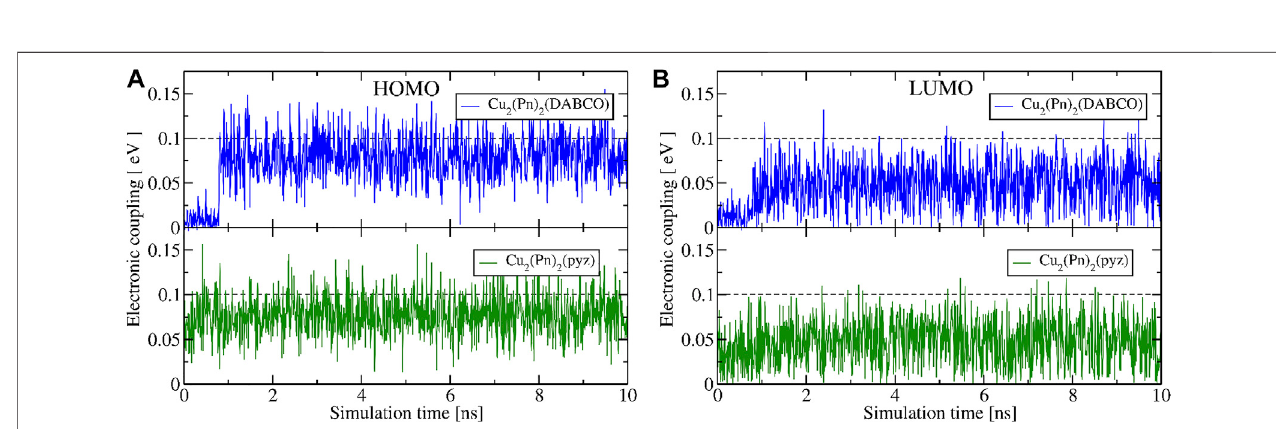
FIGURE 9 | Absolute electronic coupling elements (B3LYP/def2-SVP) between HOMO (A) and LUMO (B) orbitals of ditopic pentacene linkers extracted from the force- fi eld MD simulations of Cu 2 (Pn) 2 (DABCO) (in blue) and Cu 2 (Pn) 2 (pyz) (in green) PCU-MOFs at 298 K.